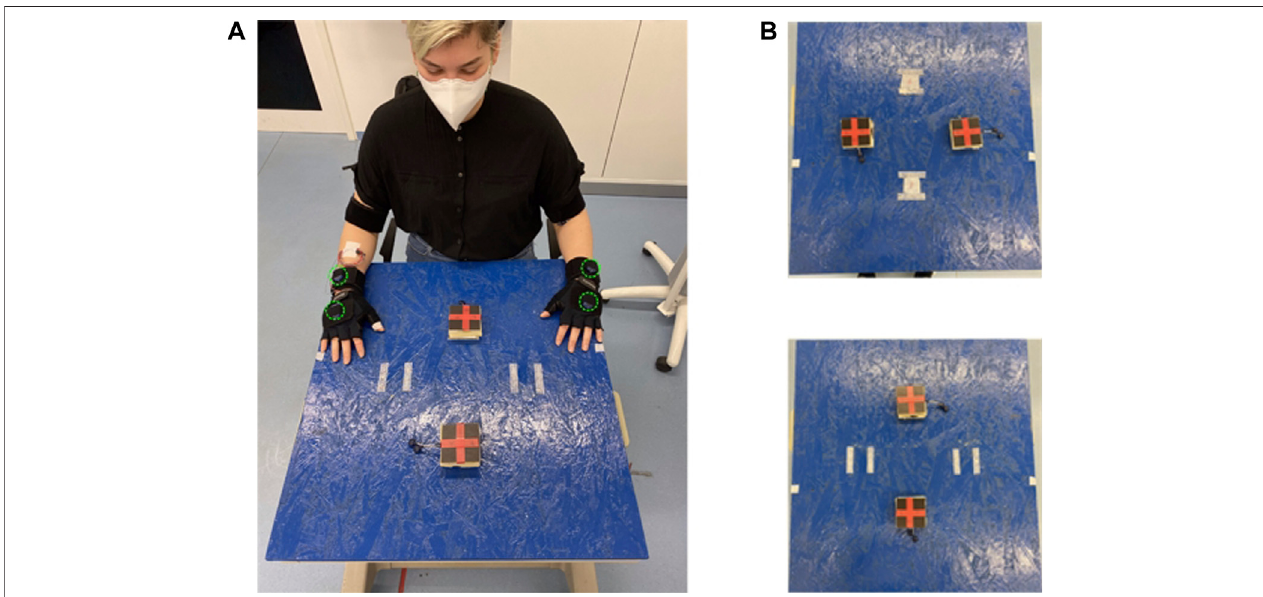
FIGURE 3 | (A) Illustration of sensor montage and experiment environments, altogether four IMUs are mounted on subject ’ s wrists and hands on both sides, marked in green. (B) Location of touching pads for different movement direction. Upper: left-right tapping direction, Lower: posterior-anterior tapping direction. The touch pads provide binary signals which are used to segment the motion signals into individual patters for training the ProMPs, see Section 4.5.